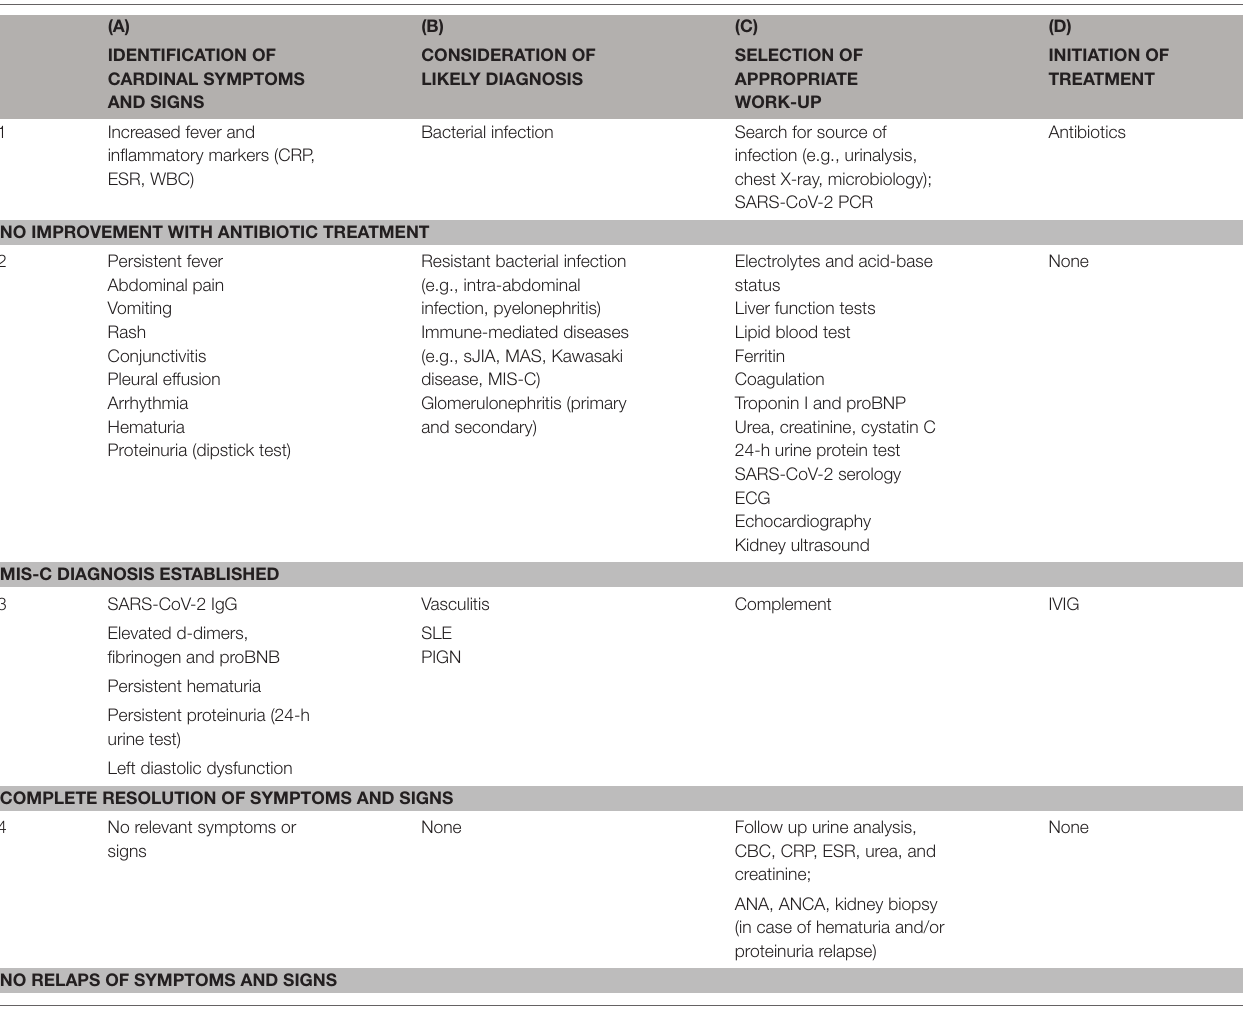
TABLE 3 | Stepwise pathway to diagnosis. (A)